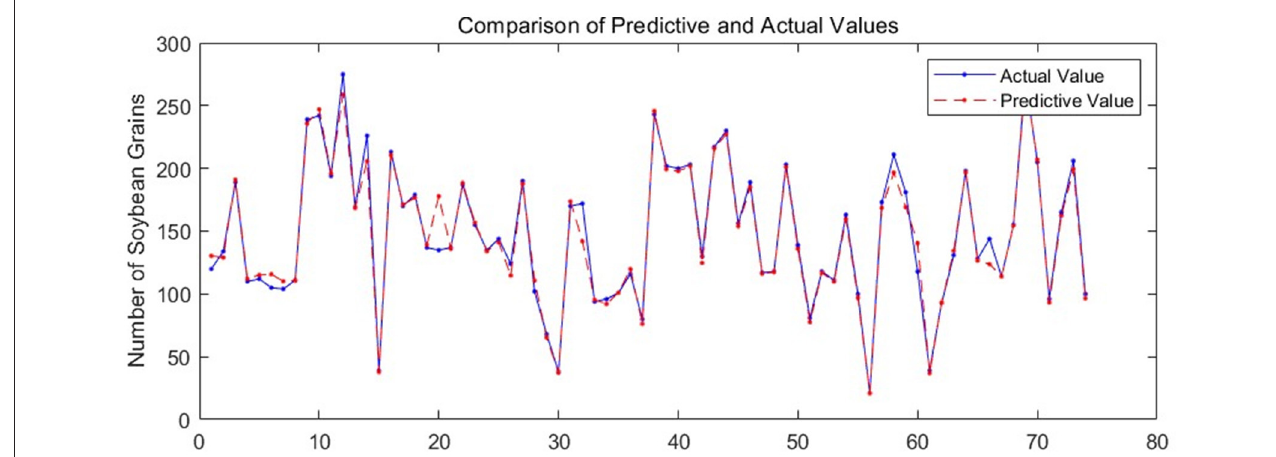
FIGURE 8 | Soybean seeds number prediction results of different plants.